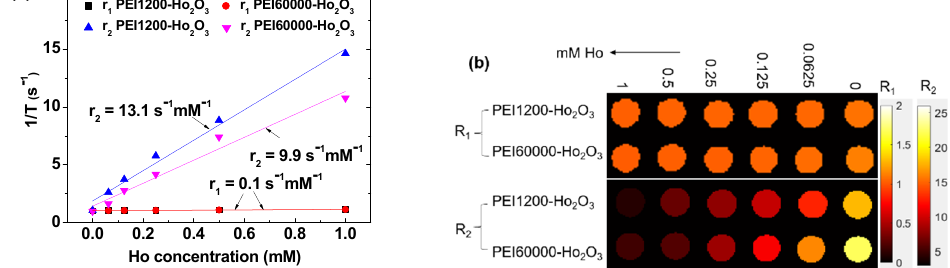
Figure 8. ( a ) Plots of inverse relaxation times 1/T 1 and 1/T 2 as a function of Ho concentration for PEI1200- and PEI60000-coated ultrasmall Ho 2 O 3 nanoparticles in aqueous media at 3.0 T and 22 °C; the slopes yield r 1 and r 2 values, respectively. ( b ) R 1 and R 2 map images.